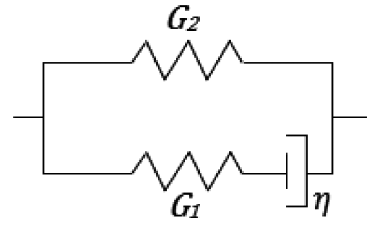
Fig. 1. Linear standard